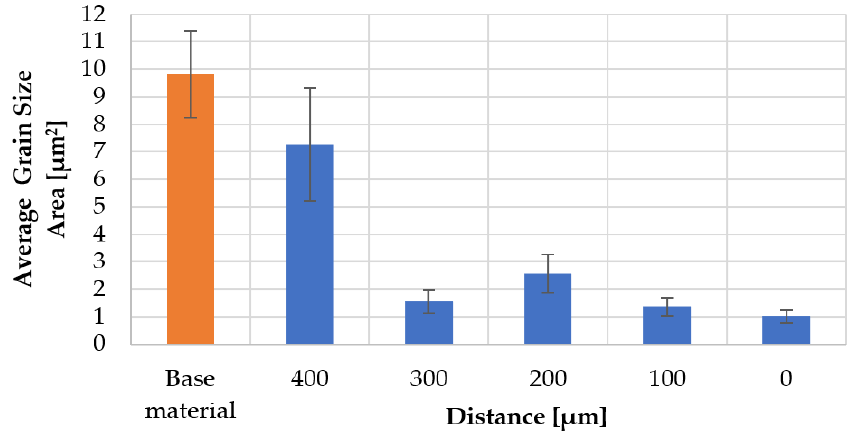
Figure 10. Inverse pole figure (IPF) maps with HAGBs, and GOS parameter images of measurement